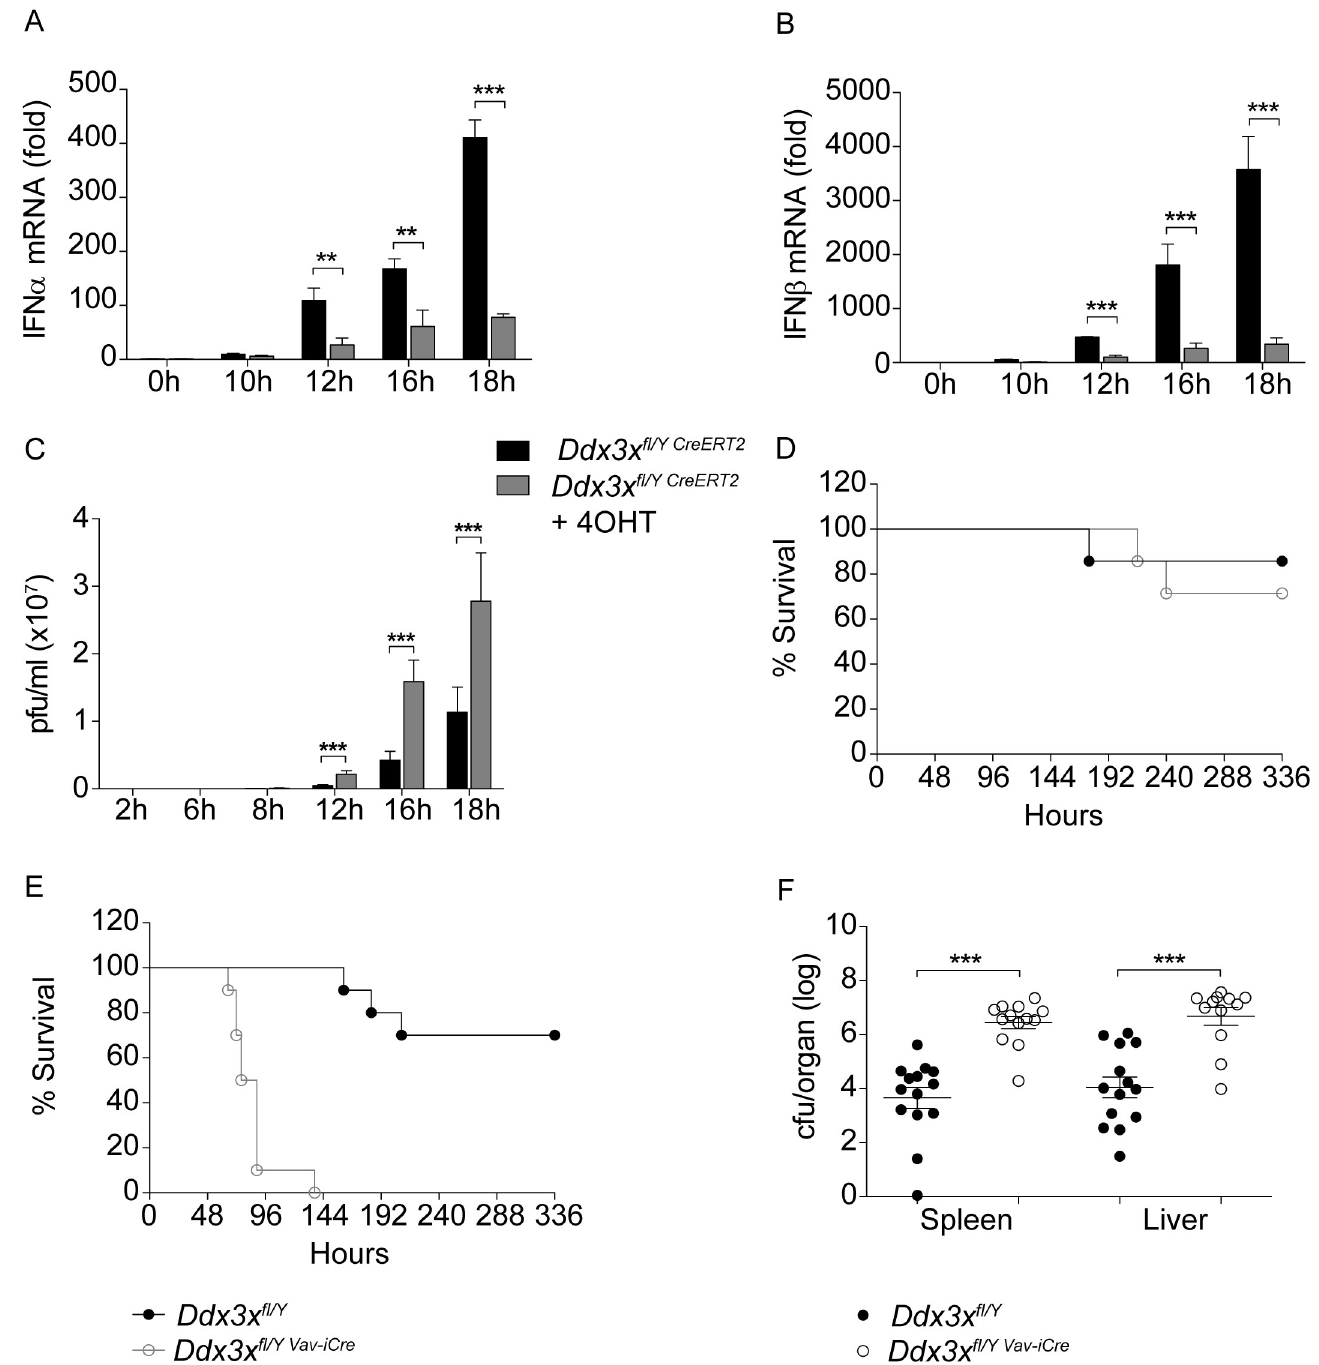
Fig 2. Innate immunity of DDX3X-deficient cells and of Ddx3x fl/y Vav-iCre mice to VSV and Listeria monocytogenes infection . A, B WT MEFs, or MEFs derived from Ddx3x fl/y CreERT2 mice and treated with 4-OHT to delete Ddx3x were infected with VSV at an MOI of 0,1. After the indicated periods, RNA was isolated and pan-Ifna (A) or Ifnb (B) mRNA expression was determined by qPCR. Lines represent the mean +/- standard deviation (SD). Statistical significance was calculated using the unpaired, two-tailed Student’s t -test. � P < 0.05, �� P < 0.01, ��� P < 0.005. C Supernatants from cells infected with VSV at an MOI of 0.1 were collected and viral loads at the indicated times were measured by plaque-forming unit (pfu) assay. Lines represent the mean +/- standard deviation (SD). Statistical significance was calculated using the unpaired, two-tailed Student’s t -test. � P < 0.05, �� P < 0.01, ��� P < 0.005. D Ddx3x fl/y and Ddx3x fl/y Vav-iCre mice (n = 7) were infected intravenously with 10 6 pfu of VSV. Survival was monitored for the indicated period of time. Statistical significance was calculated using the Log-rank (Mantel-Cox) test and Gehan-Breslow-Wilcoxon test. Differences between mouse genotypes did not reach statistical significance. E Ddx3x fl/y and Ddx3x fl/y Vav-iCre mice (n = 10) were injected intraperitoneally with 1,6x10 5 CFU L . monocytogenes (strain EGD). Survival was monitored daily for the indicated period. Statistical